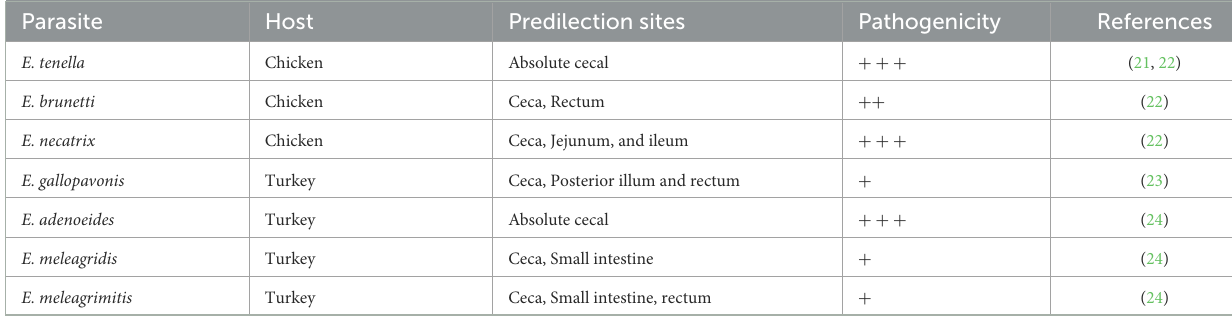
TABLE 1 The species responsible for cecal coccidiosis in avian